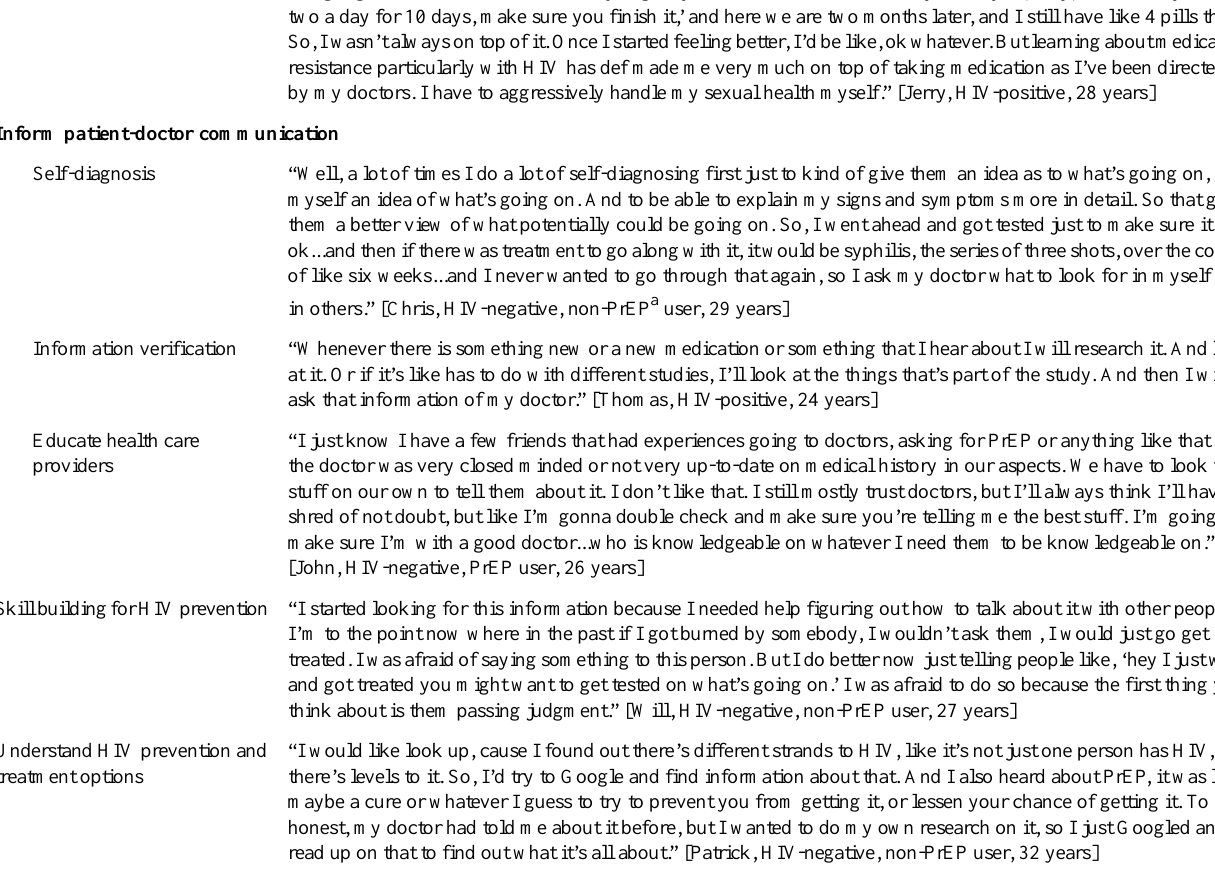
Illustrative quotes from participantsInterview